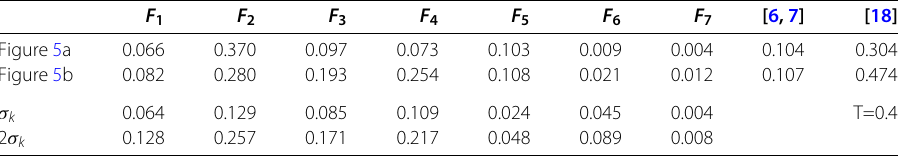
Table 2 Comparison between the proposed method and the existing method in Fig. 5 F 1 F 2 F 3 F 4 F 5 F 6 F 7 [6, 7] [18] Figure 5a 0.066 0.370 Figure 5b